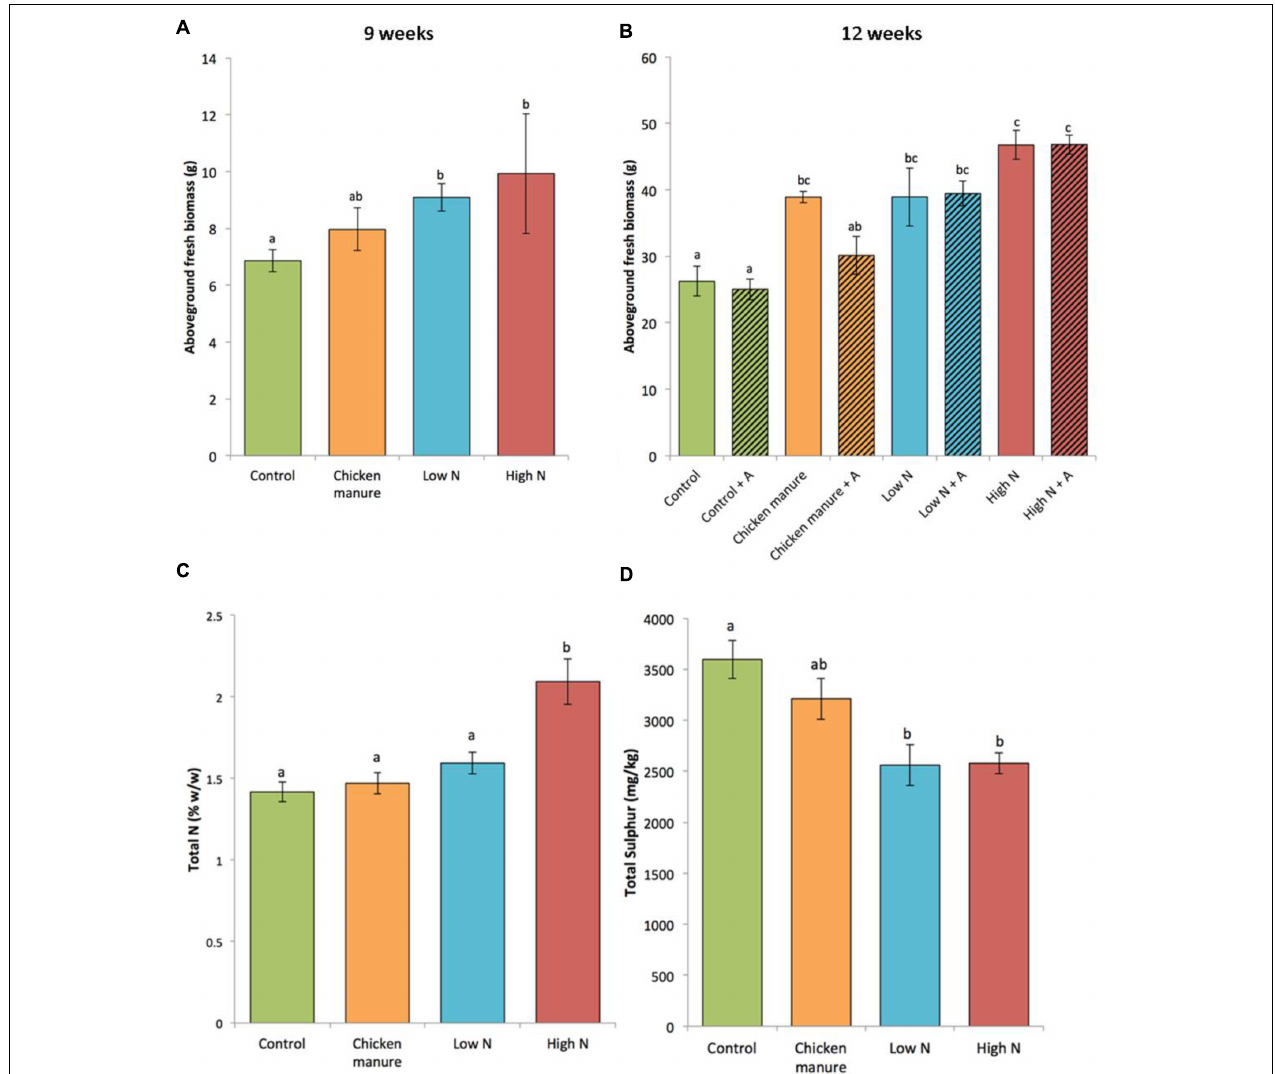
FIGURE 2 | Comparison of the plant growth parameters under different fertilizer and aphid treatments ( + A indicates plants infested with aphids) (mean ± standard error). (A) Aboveground fresh weight of 9-week-old plants ( n = 10, except HN n = 7); (B) aboveground fresh weight of 12-week-old plants without (open bars, n = 3) and with aphids (hatched bars, n = 5); (C) total foliar nitrogen (N) of 12 week-old plants ( n = 3); (D) total foliar sulfur (S) of 12-week-old plants ( n = 3). Different letters above the bars indicate significant